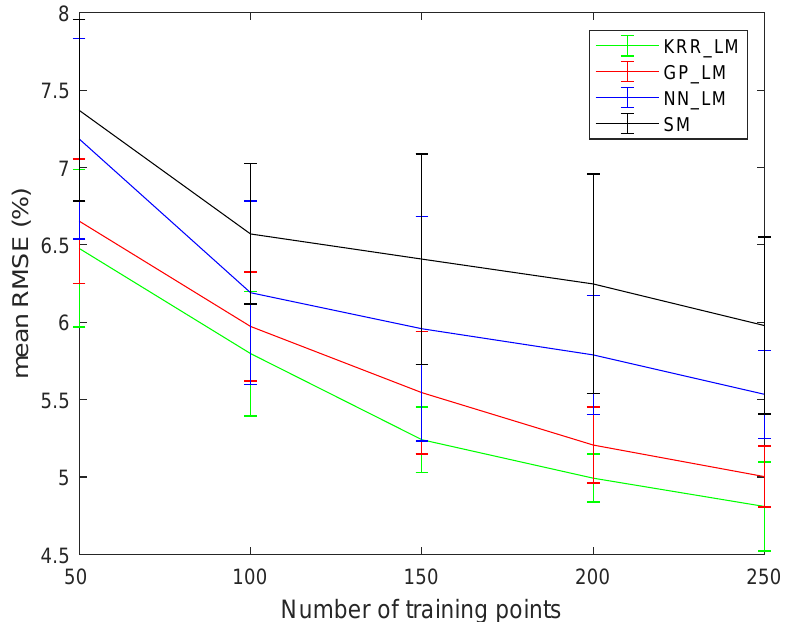
Figure 10. RMSE (100 runs) obtained by the four studied supervised methods as a function of the applied number of training samples in the drill core